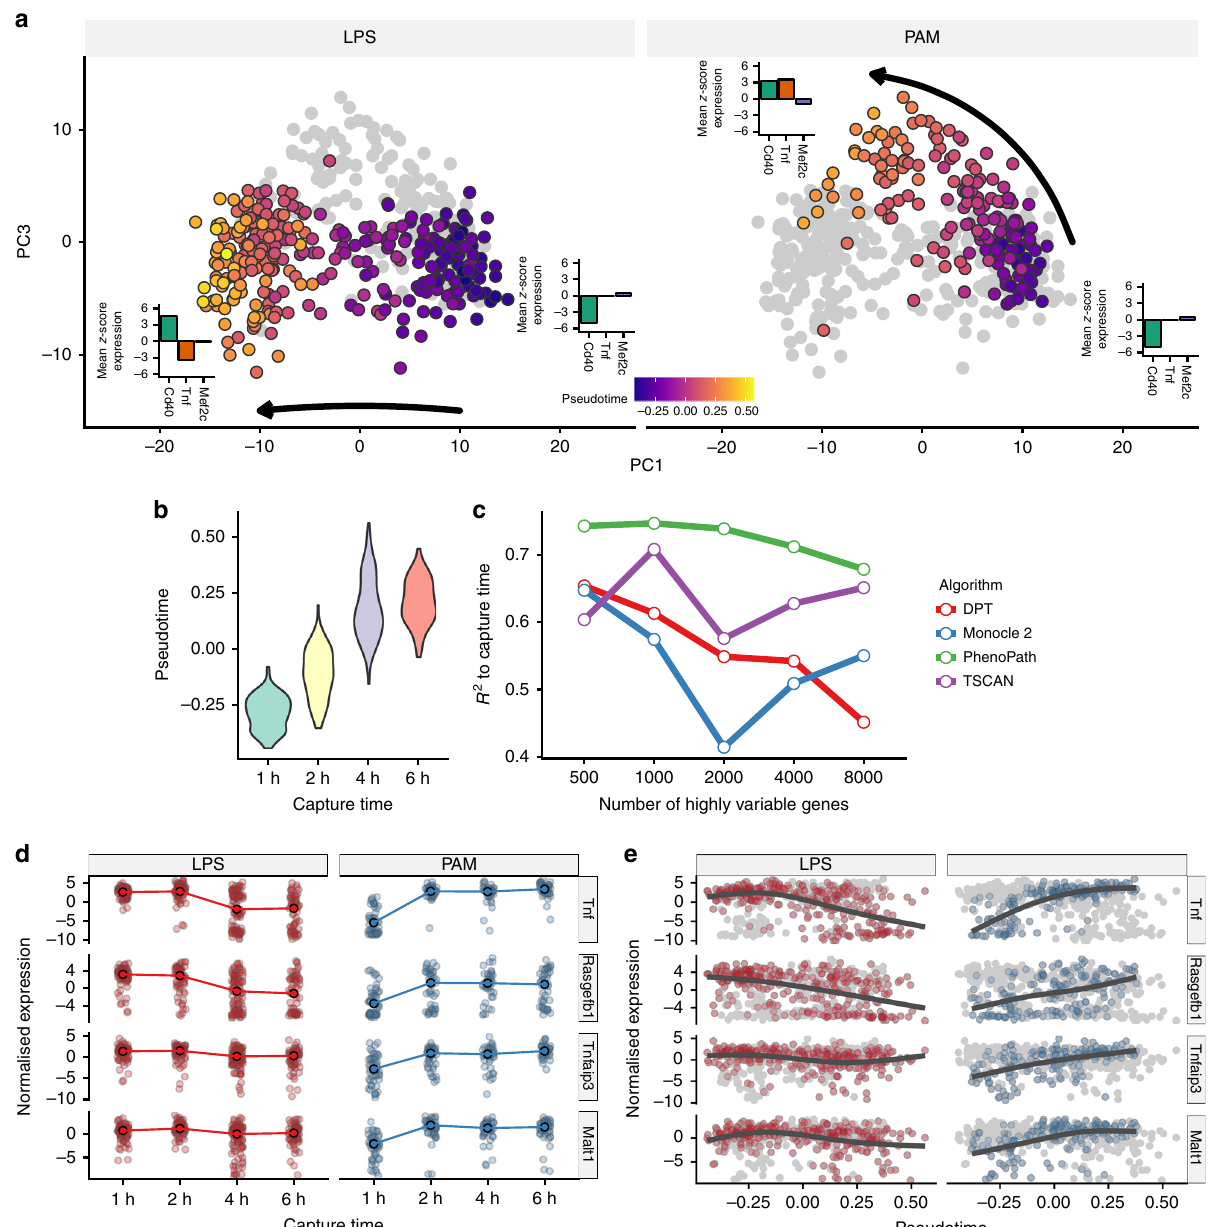
Fig. 2 PhenoPath pseudotime analysis of single-cell RNA-sequencing data under perturbation. a PCA representation of the PhenoPath pseudotime fi t shows distinct trajectories of the dendritic cells under LPS or PAM stimulation, with an initial common cell state before transcriptomic divergence as the different stimulants are applied. b The inferred pseudotimes recapitulate the physical progression of the cells with R 2 = 0.68 to the capture times. c The pseudotimes inferred by PhenoPath recapitulate the physical progression of the cells more accurately than three state-of-the-art pseudotime algorithms across a range of input genes. d Expression of Tnf , Rasgefb1 , Tnfaip3 , and Malt1 — the four genes with the largest interaction effects — as a function of physical capture time strati fi ed by applied stimulant. e The same four genes from ( d ) as a function of physical capture time. Strikingly, Tnf is upregulated under PAM exposure yet downregulated under LPS